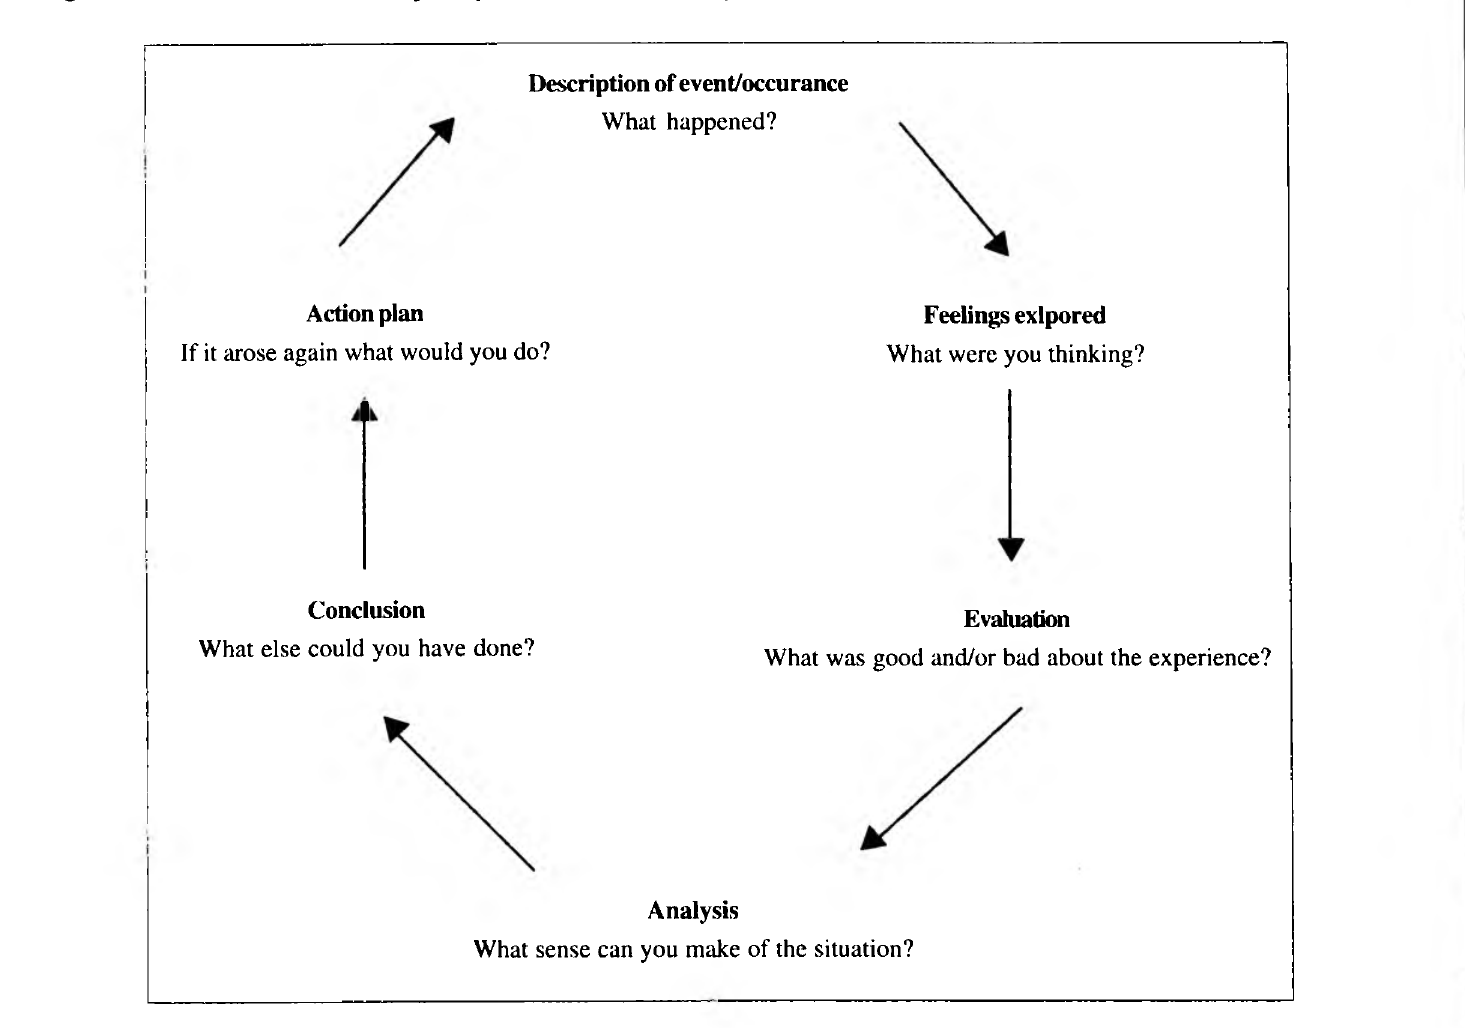
Figure 1 : Gibbs’s Reflective Cycle (Palmer et a l.,